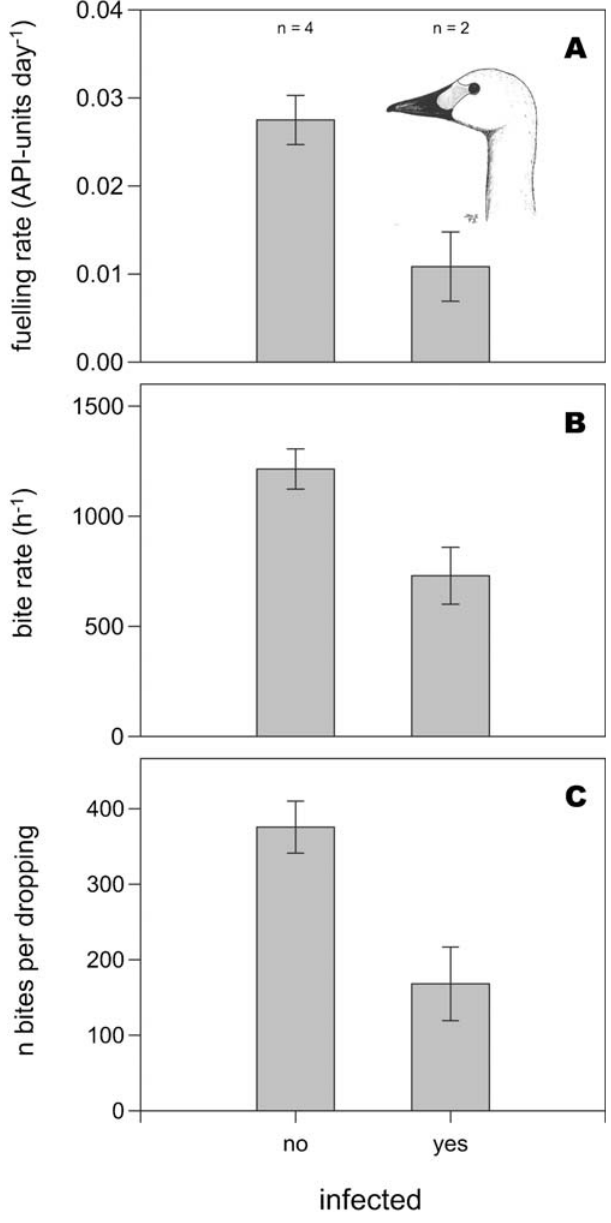
Figure 4. Feeding parameters as a function of health status. Compared to healthy birds, infected birds ( A ) fuelled slower, ( B ) took fewer bites per hour, and ( C ) took fewer bites per produced dropping. Because of a seasonal increase observed in bite rate ( p , 0.05 when all observations pooled), bite rate plotted in ( B ) were standardized to 1 February. In all graphs, bars give least-square means, error bars are